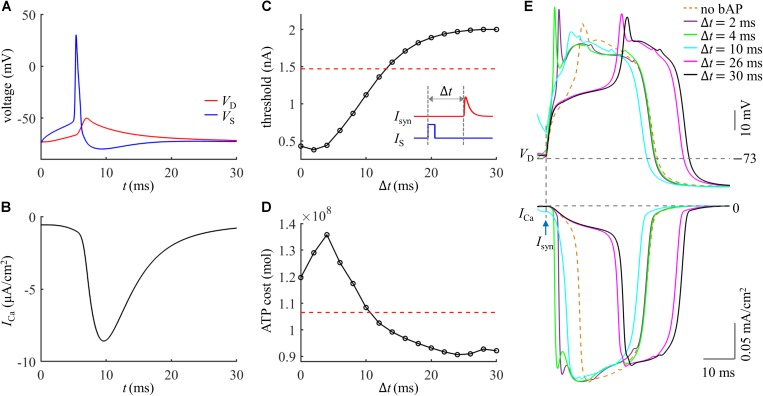
(A) Time courses of VS and VD in the case of a bAP. (B) Time course of Ca2+ current ICa during a bAP. (C) Threshold for activation of a Ca2+ spike in the active dendrite, which was plotted as a function of time interval Δt. Inset: Isyn was injected at Δt after the onset of IS. The red dotted line indicated the threshold without a bAP. (D) ATP cost of a Ca2+ spike as a function of Δt. The red dotted line indicated the spike cost without a bAP. (E) Top panel: superposition of Ca2+ spikes generated at different values of Δt. Bottom panel: Ca2+ current ICa underlying each dendritic spike. In (A,B), Isyn = 0 nA. In (D,E), Isyn = 2 nA. Somatic input was IS = 1.9 nA.